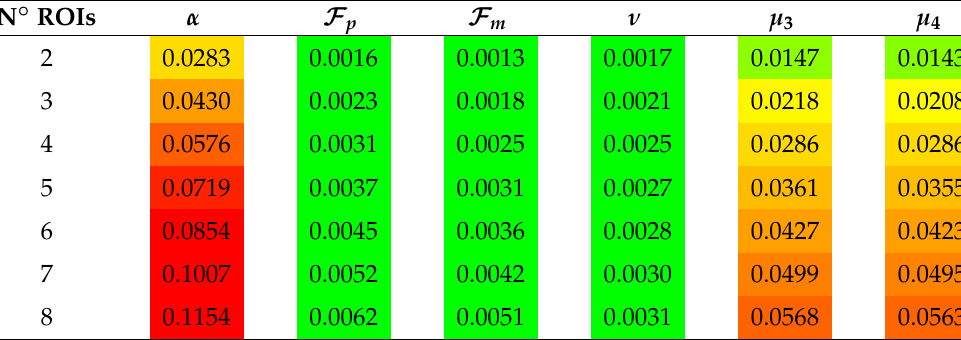
Table 3. Values expressed in seconds of the time spent by the thermal data processing